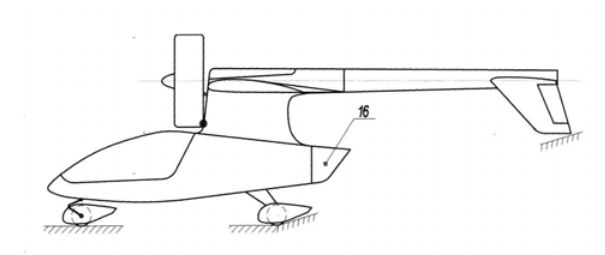
Fig. 6. Single-engine type of the UAV developed on the basis of the twin-engine